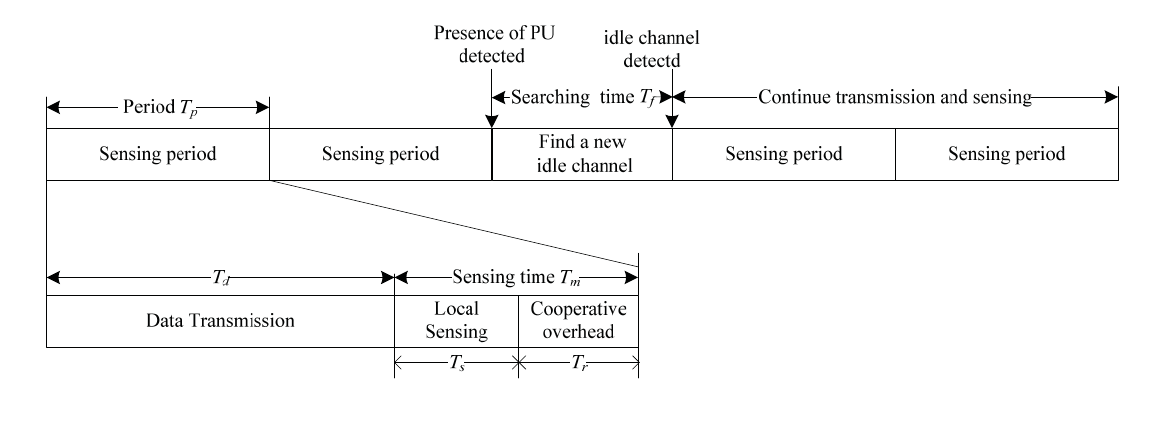
Figure 3. Periodic cooperative sensing